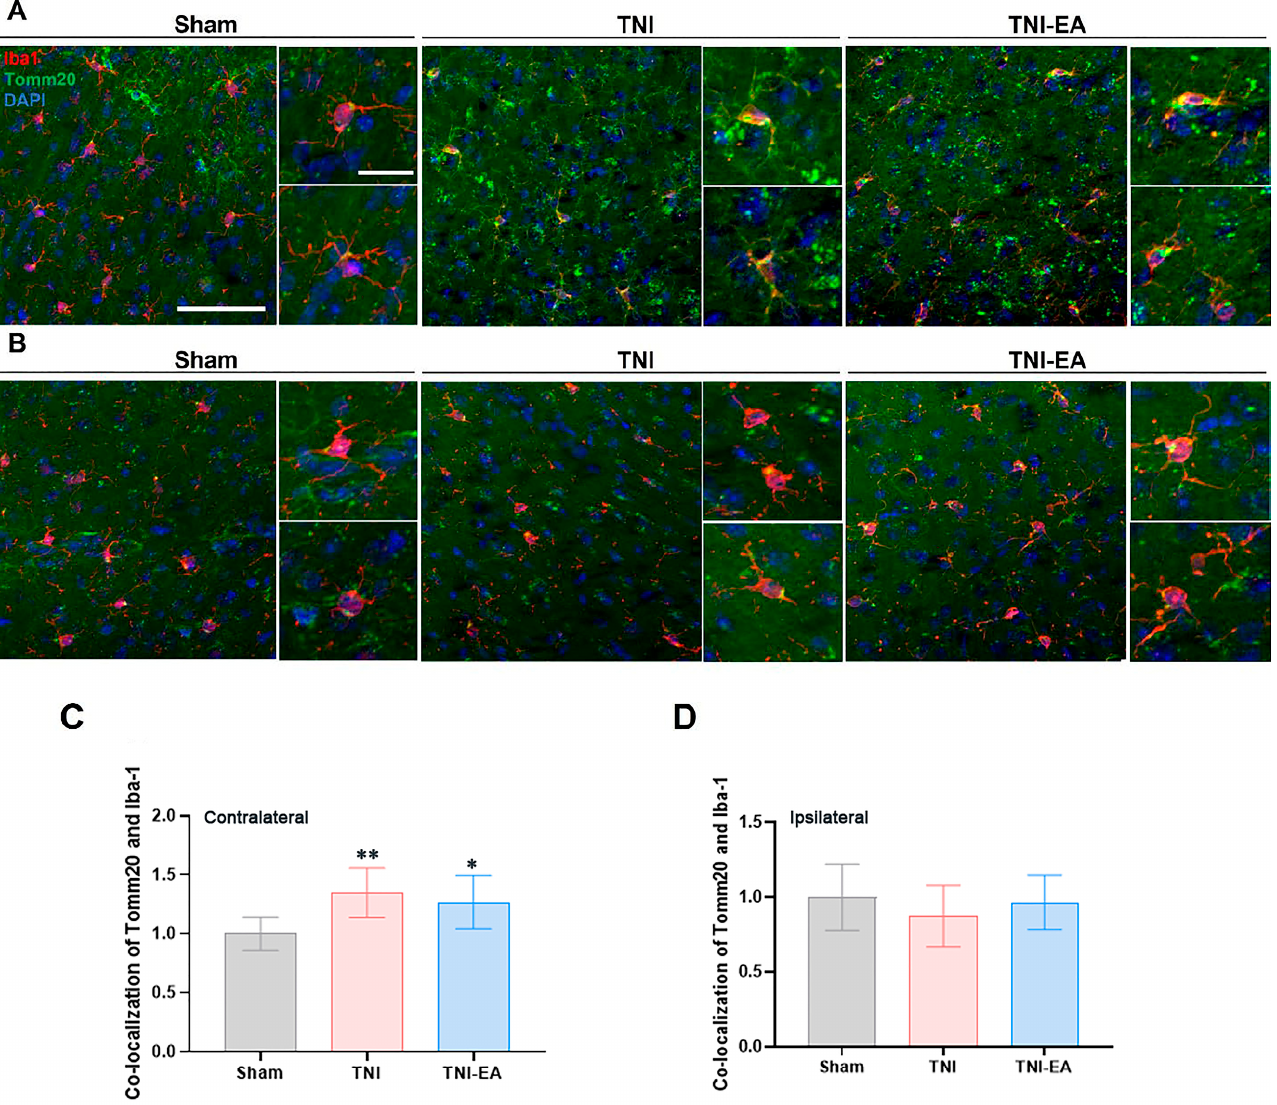
Figure 7. Expression of Tomm20 in microglia in contralateral ( A ) and ipsilateral ( B ) ACC in sham, TNI, and TNI-EA mice. Colocalization of Iba1 and Tomm20 was increased in the contralateral ACC of TNI mice, and EA treatment did not alleviate this alteration ( C ). The expression of Tomm20 in microglia was similar in the ipsilateral ACC of sham, TNI, and TNI-EA mice ( D ). Scale bars in panel A: 50 µm (left) and 20 µm (right). *, **: p < 0.05, 0.01 compared with Sham group; one-way ANOVA followed by Tukey’s multiple comparisons test; N = 7–8.